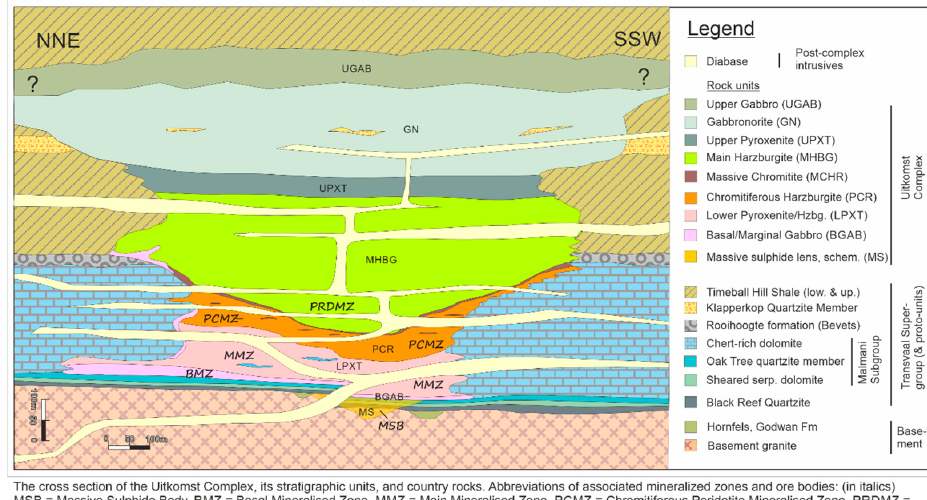
Figure 3. An idealised schematic cross section of the Uitkomst Complex after [5].